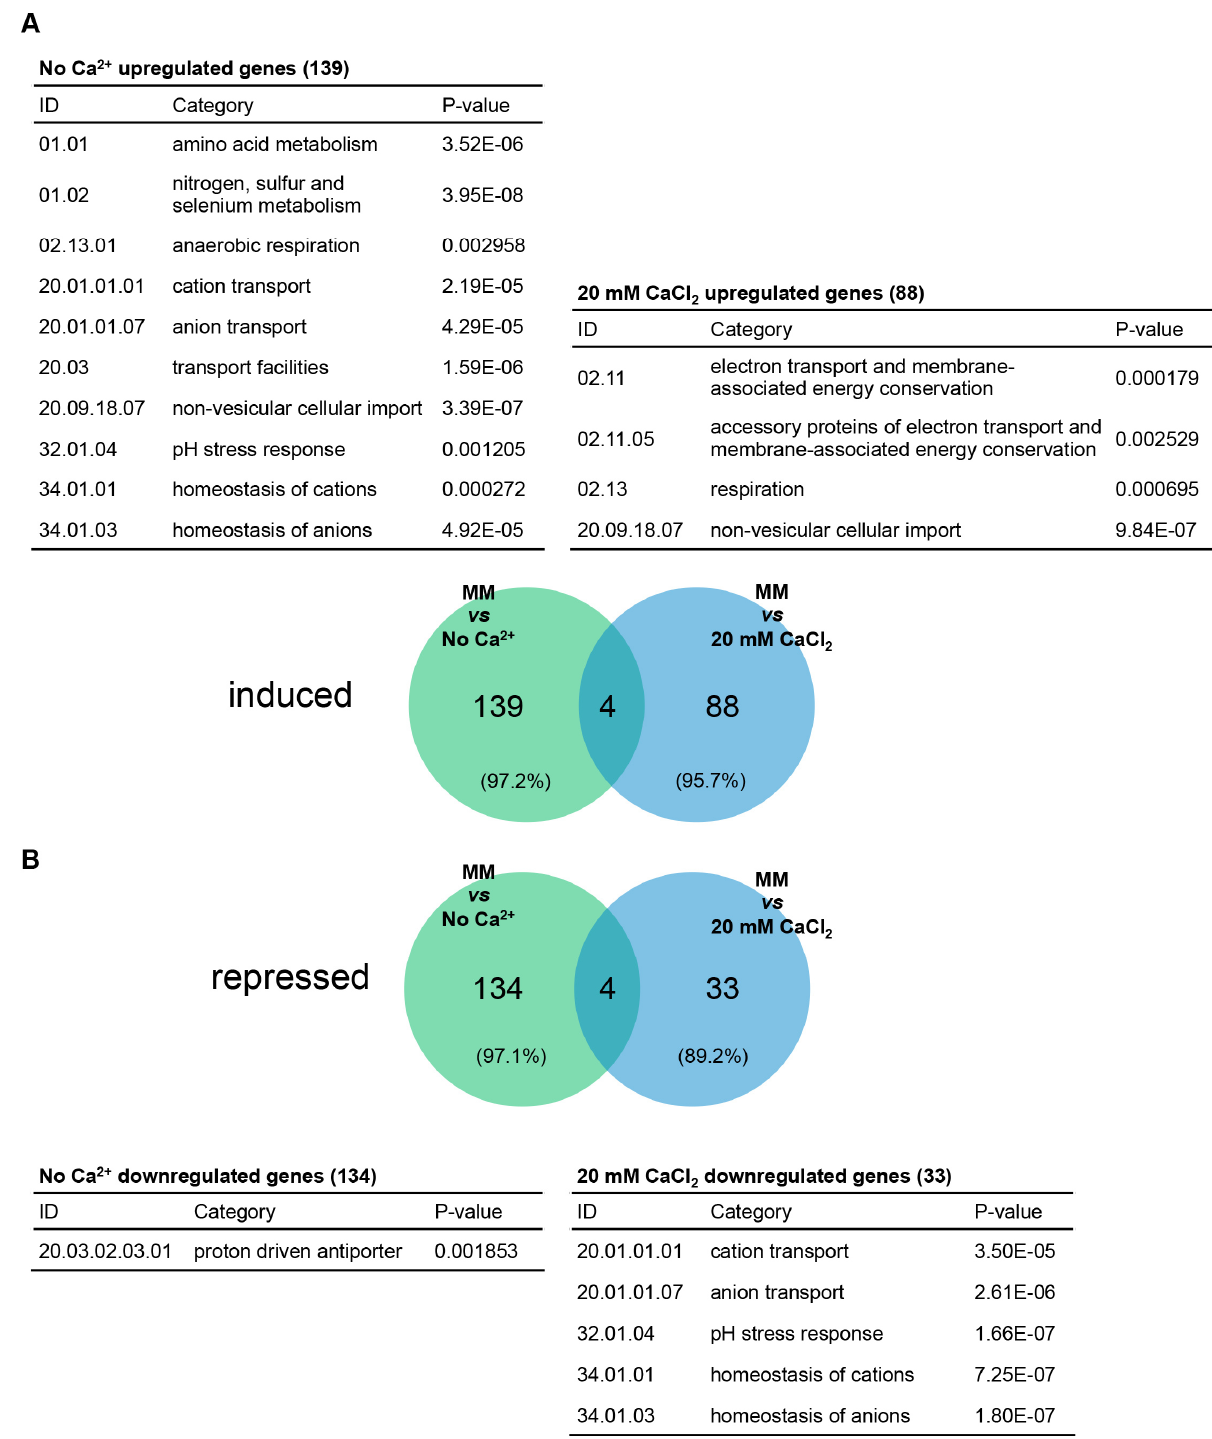
FIGURE 5: Functional enrichment analysis of the transcriptional alterations caused by limited or excess Ca 2+ . (A-B) The transcriptional response to the absence or excess of Ca 2+ was investigated by building Venn diagrams showing the distribution of genes with induced (A) or repressed (B) expression in no Ca 2+ and 20 mM CaCl 2 medium. Lists of enriched categories are